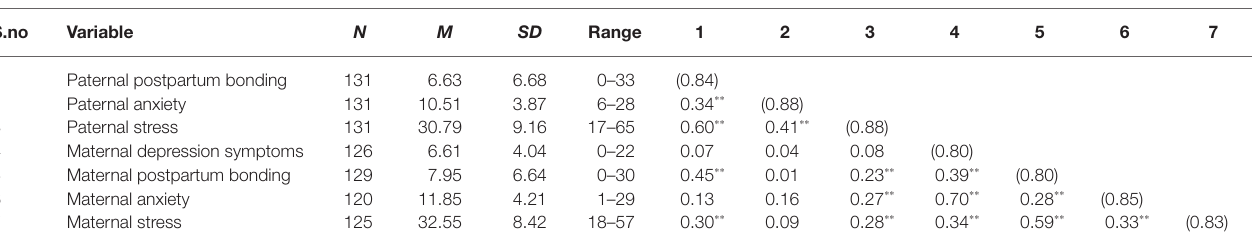
TABLE 2 | Means, SDs, and zero-order correlations among study